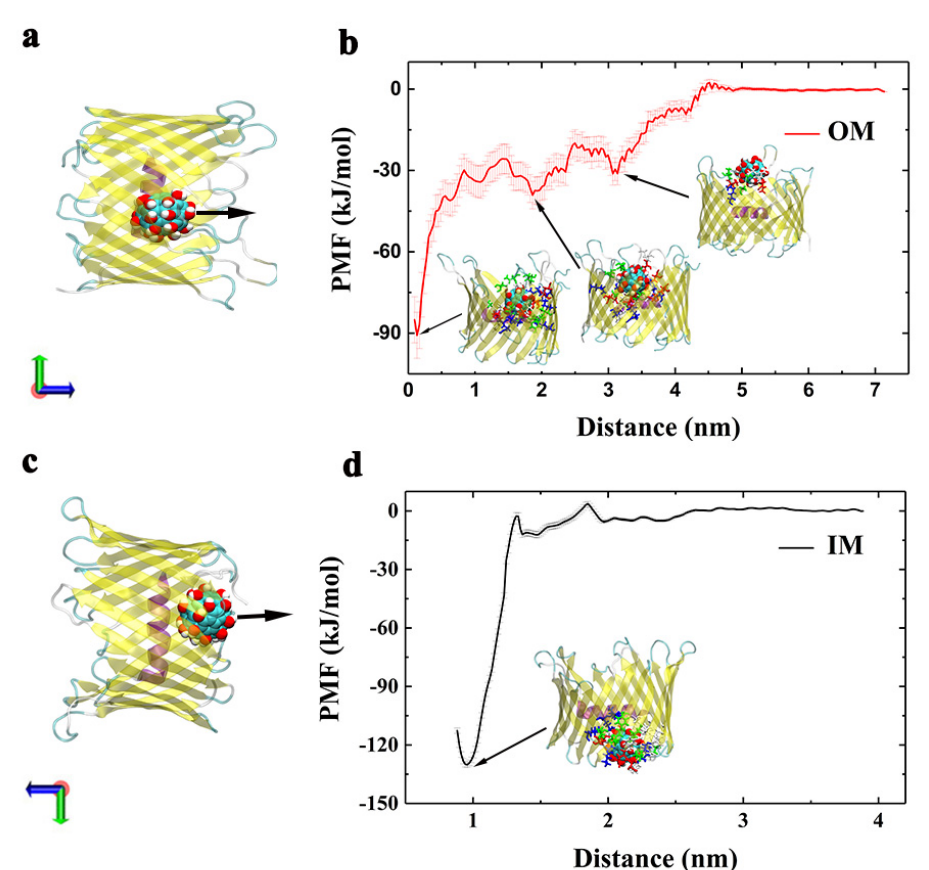
Figure 8. The binding free energies of Gd@C 82 (OH) 22 on the hVDAC1 that permeated the channel from OM ( a , b ) and IM sides ( c , d ), respectively. The initial structures used in the PMF calculations are shown in panel ( a , c ); the arrows indicate the pulling directions. The structures that correspond to the energy wells are inset in the panels ( c , d ). Their contact residues in each structure are shown with stick and colored based on residue type.